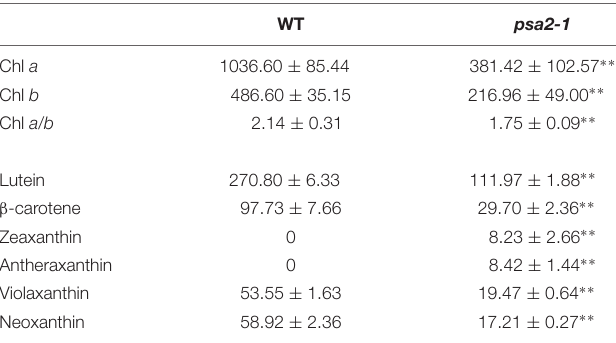
FIGURE 6 | High-performance liquid chromatography (HPLC) analysis of pigments in rosette leaves of the psa2-1 mutant (red) and the wild-type plants (black). Peaks are neoxanthin (Nx), internal standard (IS), violaxanthin (Vx), antheraxanthin (Ax), lutein (L), zeaxanthin (Zx), β -carotene ( β C), and chlorophylls (Chl a and Chl b ). Insets are spectra profiles of Ax and Zx. TABLE 1 | Leaf pigment profile of the Arabidopsis thaliana wild-type (WT) and psa2-1 mutant plants ( µ g/g fresh